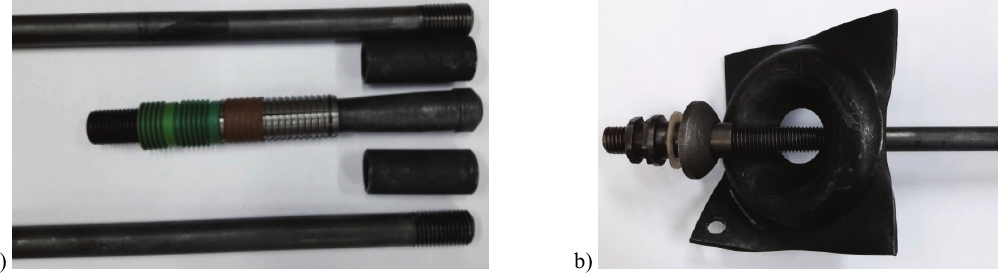
Fig. 10. Elements of expansion long rock bolt OB25: a) expansion shell, bolt rods and connecting sleeves, b) bearing plate with a sleeve nut, dome plate, gasket and smooth rod (photo by K.